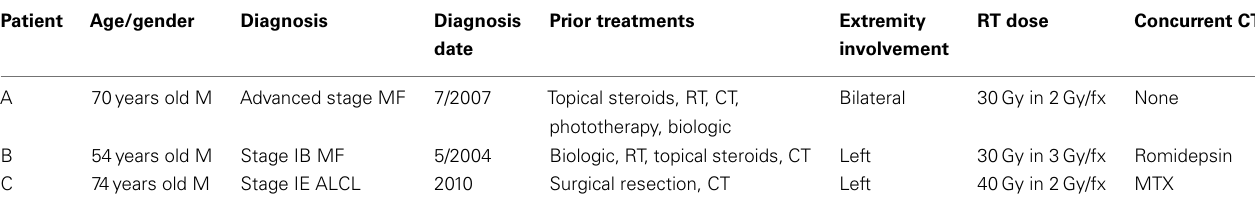
Table 1 | Patient data and medical histories .